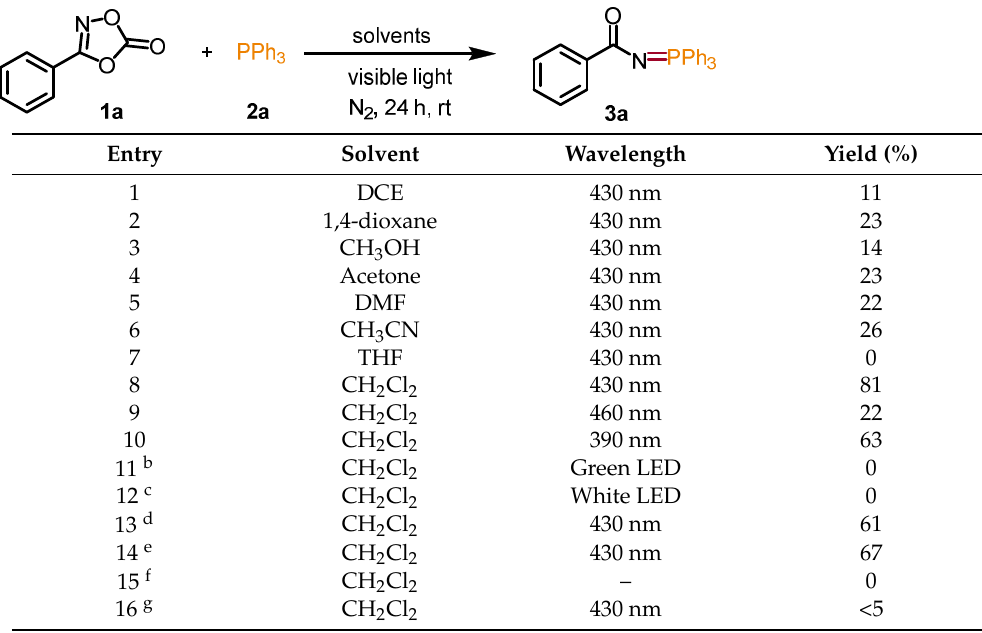
Table 1. Optimization of reaction conditions a .